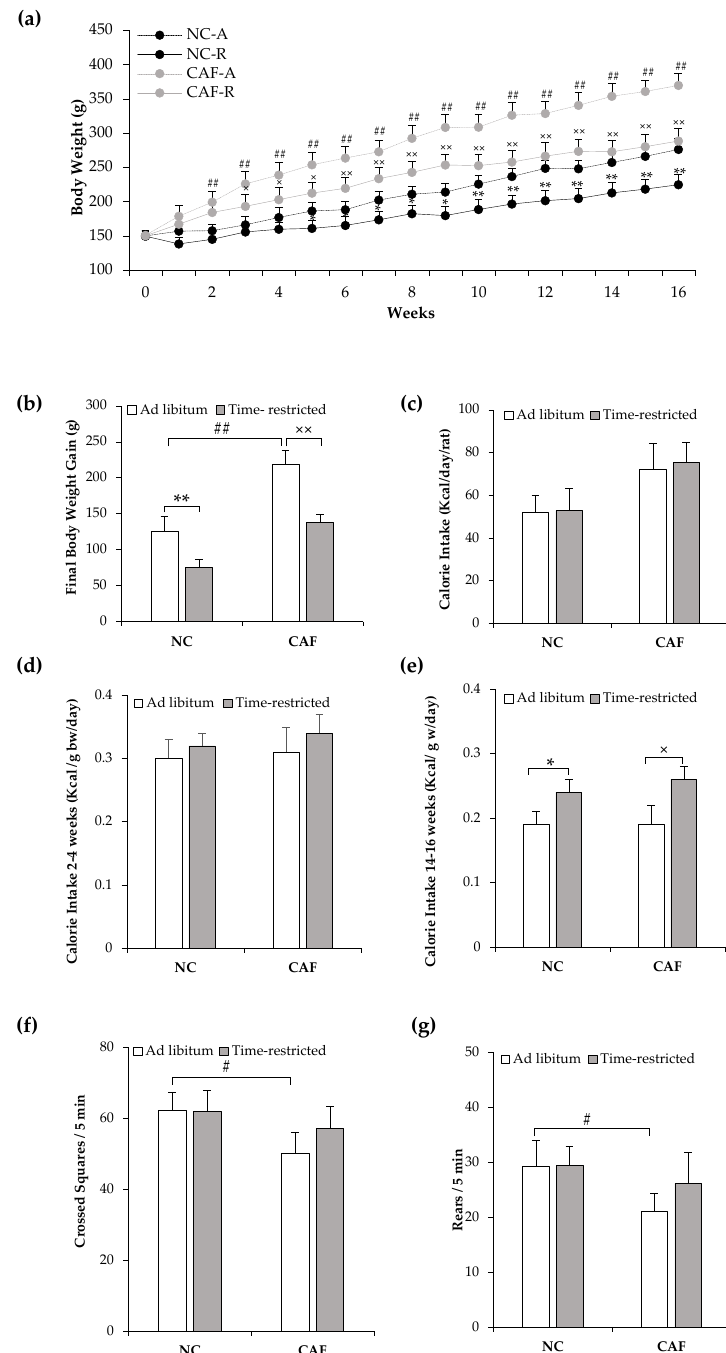
Figure 2. E ff ects of time-restricted feeding on body weight change, calorie intake, and locomotor activity in normalchow- and cafeteria-fed rats. ( a ) Weekly body weight change over the experiment; ( b ) final body weight gain; ( c ) total daily calorie intake; ( d , e ) daily calorie intake normalized to unit body weight: ( d ) weeks 2–4; ( e ) weeks 14–16; ( f , g ) locomotor activity on the 15th week of the experiment: ( f ) number of crossing squares; ( g ) number of rears. NC–A: normal chow ad libfeeding; NC–R: normal chow time-restricted feeding; CAF–A: cafeteria diet ad libfeeding; CAF–R: cafeteria time-restricted feeding; NC: normal chow diet; CAF: cafeteria diet; b.w: body weight. Values are means ± S.D. ( n = 6). # p < 0.05, ## p < 0.01 CAF–A vs. NC–A rats; * p < 0.05, ** p < 0.01 NC–R vs. NC–A rats; × p < 0.05, ×× p < 0.01 CAF–R vs. CAF–A rats (Mann–Whitney